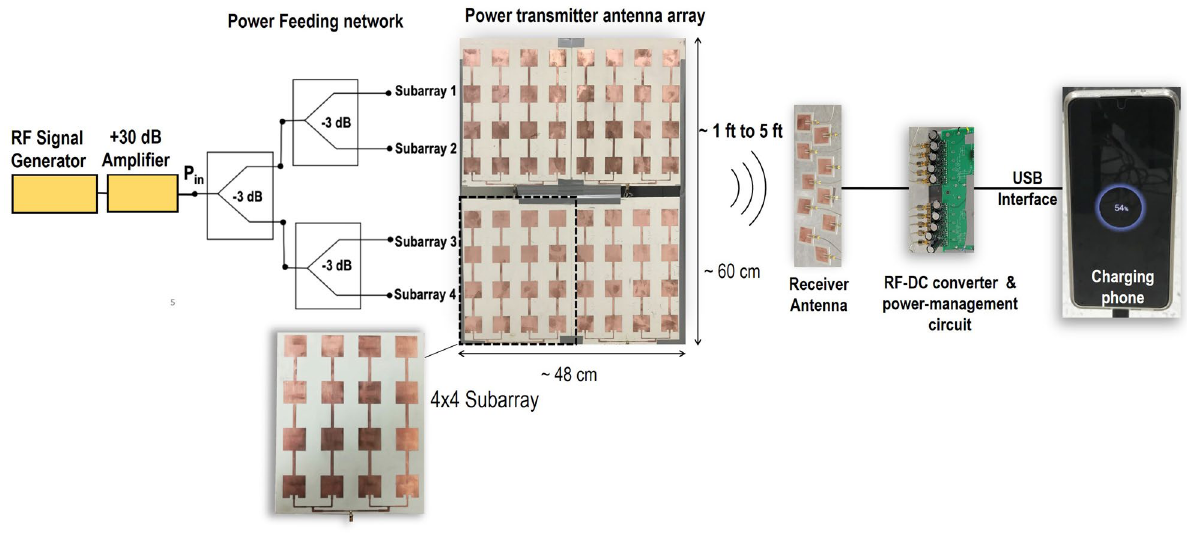
Figure 2. Wireless power transfer source panel design for the realization of in-home wireless grid. Figure drawn using Inkscape 1.1 available from https:// inksc ape. org, and integrated with real antenna, rectifier and phone